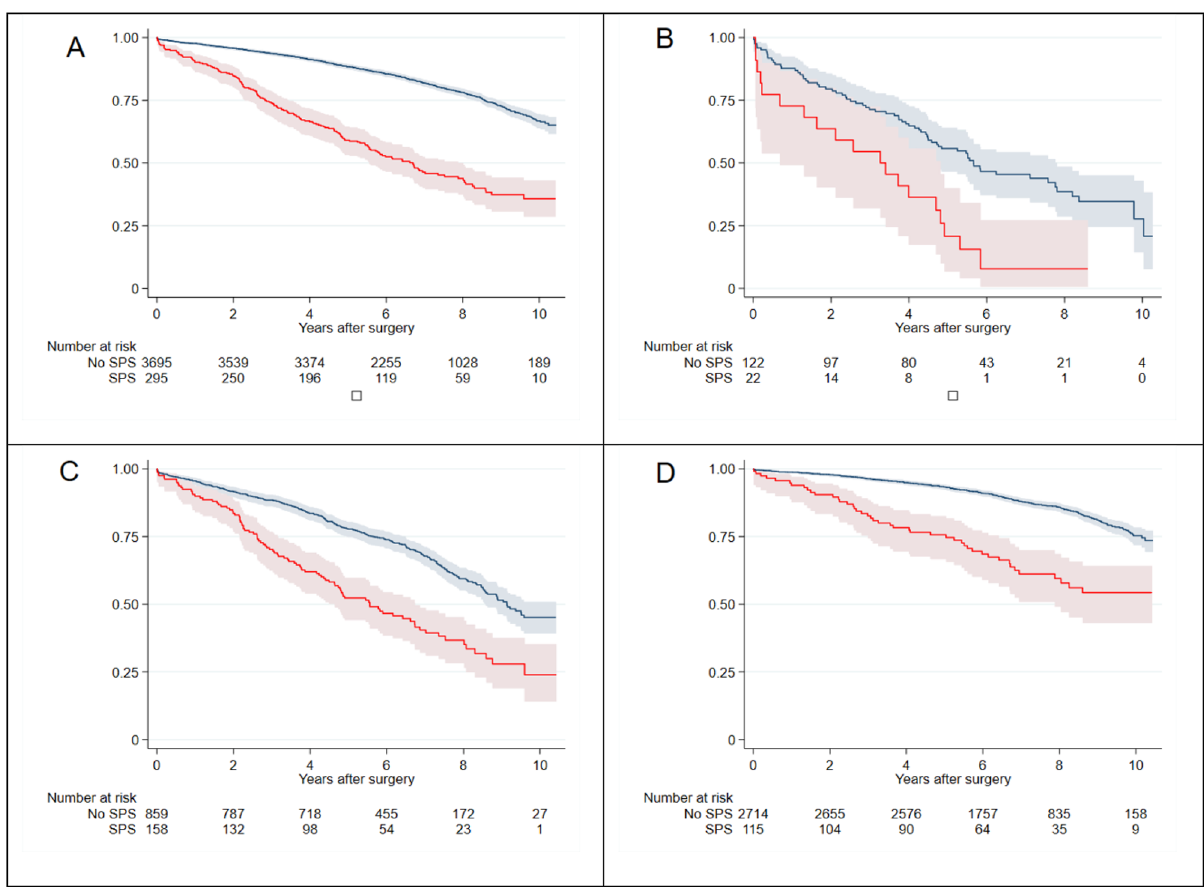
Figure 3. Survival after elective cardiac surgery for all patients, irrespective of eGFR, with Shrunken Pore Syndrome (red solid line) or without SPS (blue solid line) are seen in top left. Patients with eGFR < 30 ml/ min/1.73 m 2 are seen in top right while patients with eGFR 30–60 ml/min/1.73 m 2 and > 60 ml/min/1.73 m 2 are seen in bottom left and bottom right, respectively. Faded area represents 95% CI.